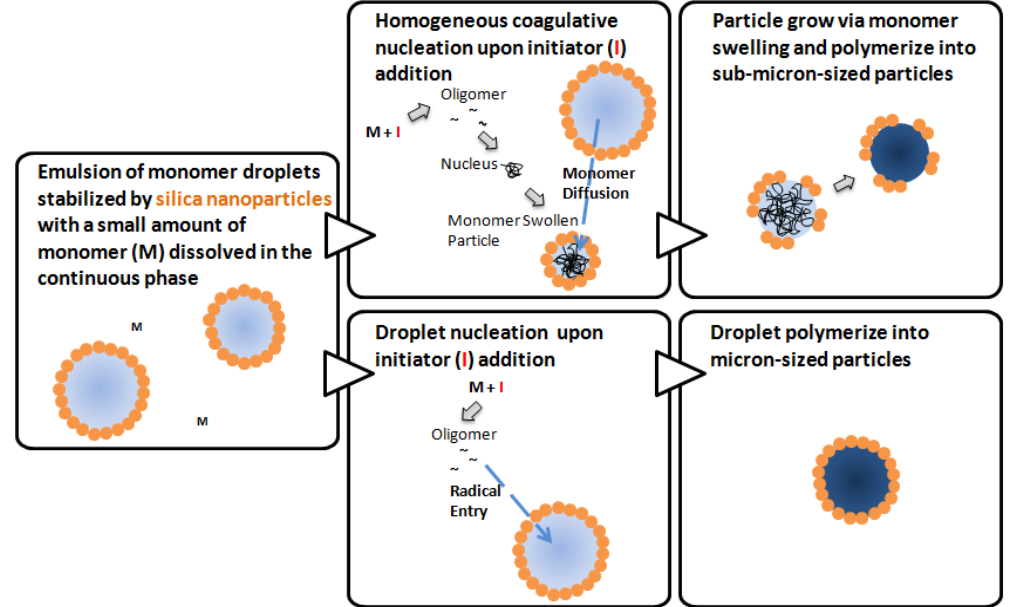
Figure 5. Schematic illustration for possible mechanisms of Pickering emulsion